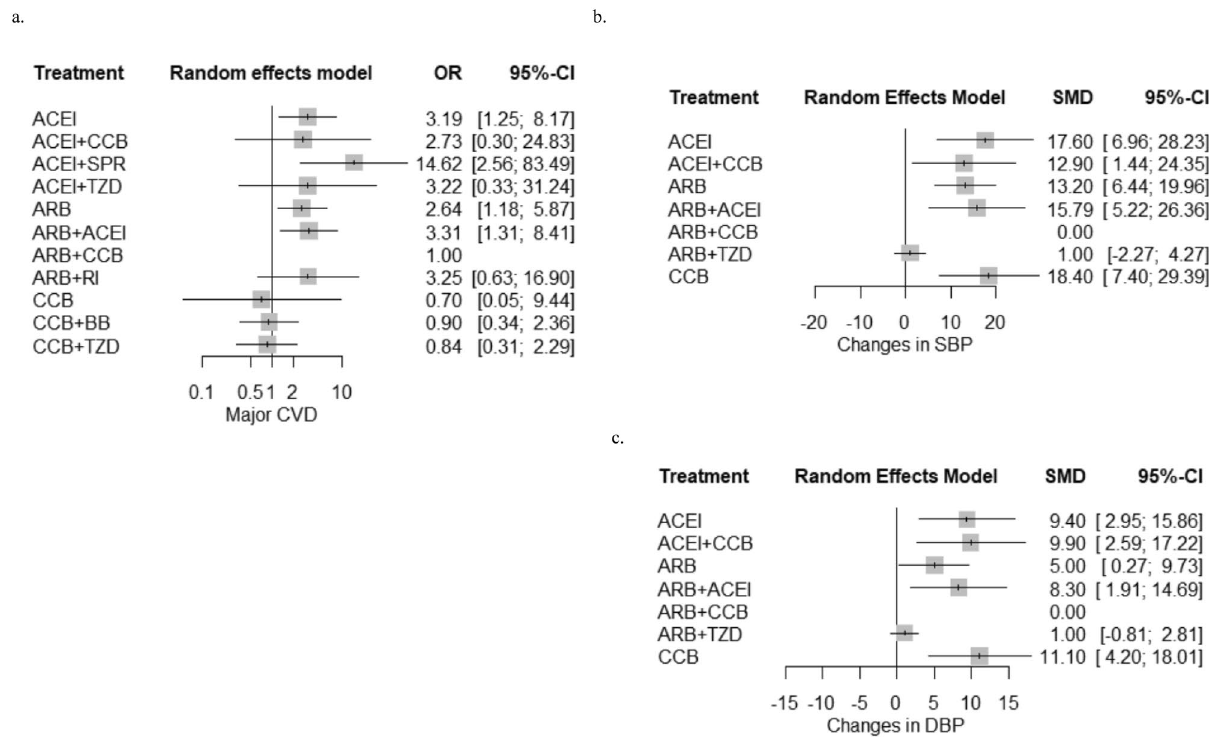
Figure 4. Cardiovascular outcomes of antihypertensive interventions in CKD patients. ( a ) Major CVD events, ( b ) changes in SBP, and ( c ) changes in DBP.